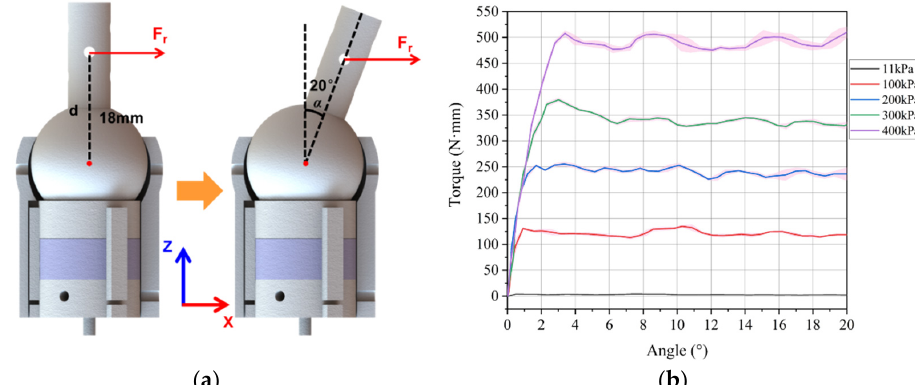
Figure 9. Experimental results of the rotational stiffness of the VSBJ at different input air pressures: ( a ) Schematic illustration of the point of application of the pulling force; ( b ) torque-angle curves at different air pressures.